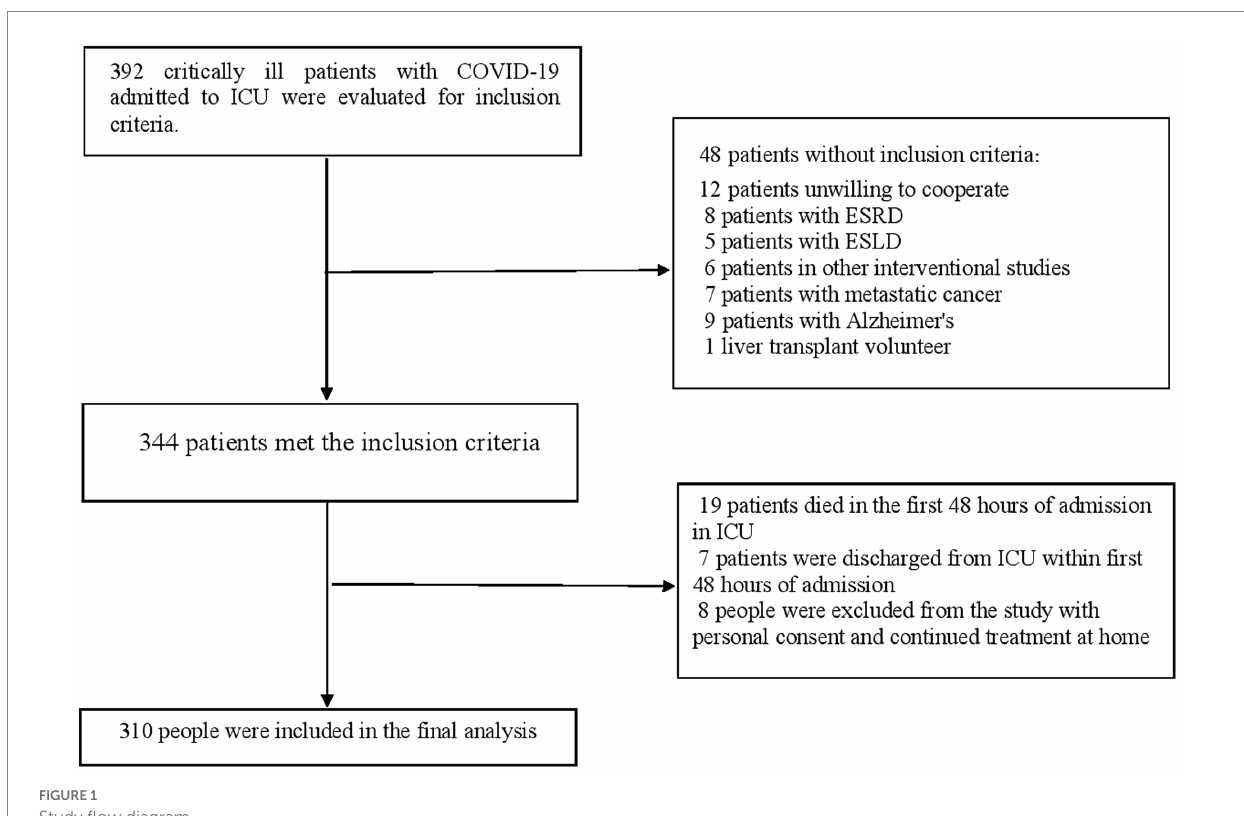
FIGURE 1 Study flow